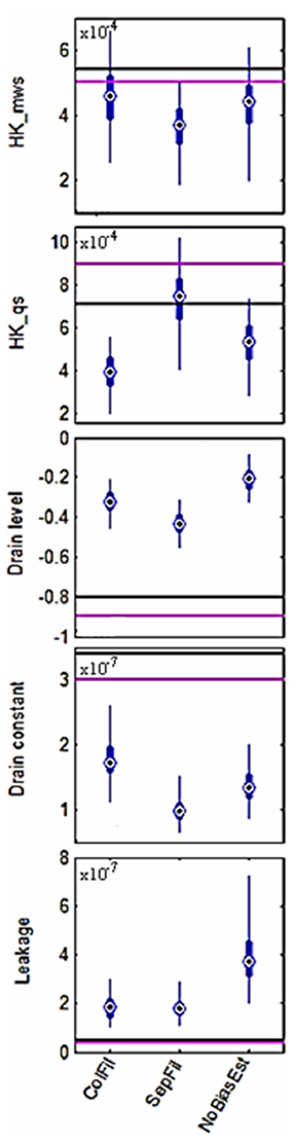
Figure 11. Spread of estimated parameters at the final update (real data). Thin blue lines show the total spread of the ensemble and thick blue lines show the 25th and 75th percentile. Dots show the mean of the ensemble. The horizontal lines show the AutoCal pa- rameter value (black line) and the base parameter value (magenta